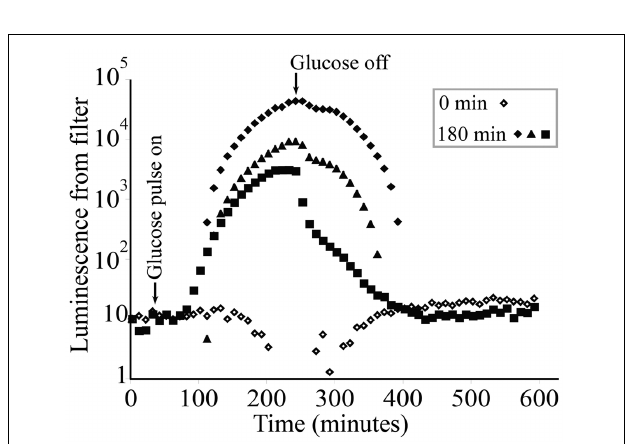
FIGURE 5 | Luminescence from populations of microbiosensor KT2440/pZKH2 established on 0.45 µ m syringe filters and receiving M9 medium at a constant flow rate of 0.5ml min − 1 . Starting at approximately 40min, 3 replicates were exposed to a 180-minute pulse of 0.1% (w/v) glucose in M9, then returned to M9 alone. Each glucose-treated replicate is shown separately to illustrate dynamics more clearly (0min indicates no glucose added).